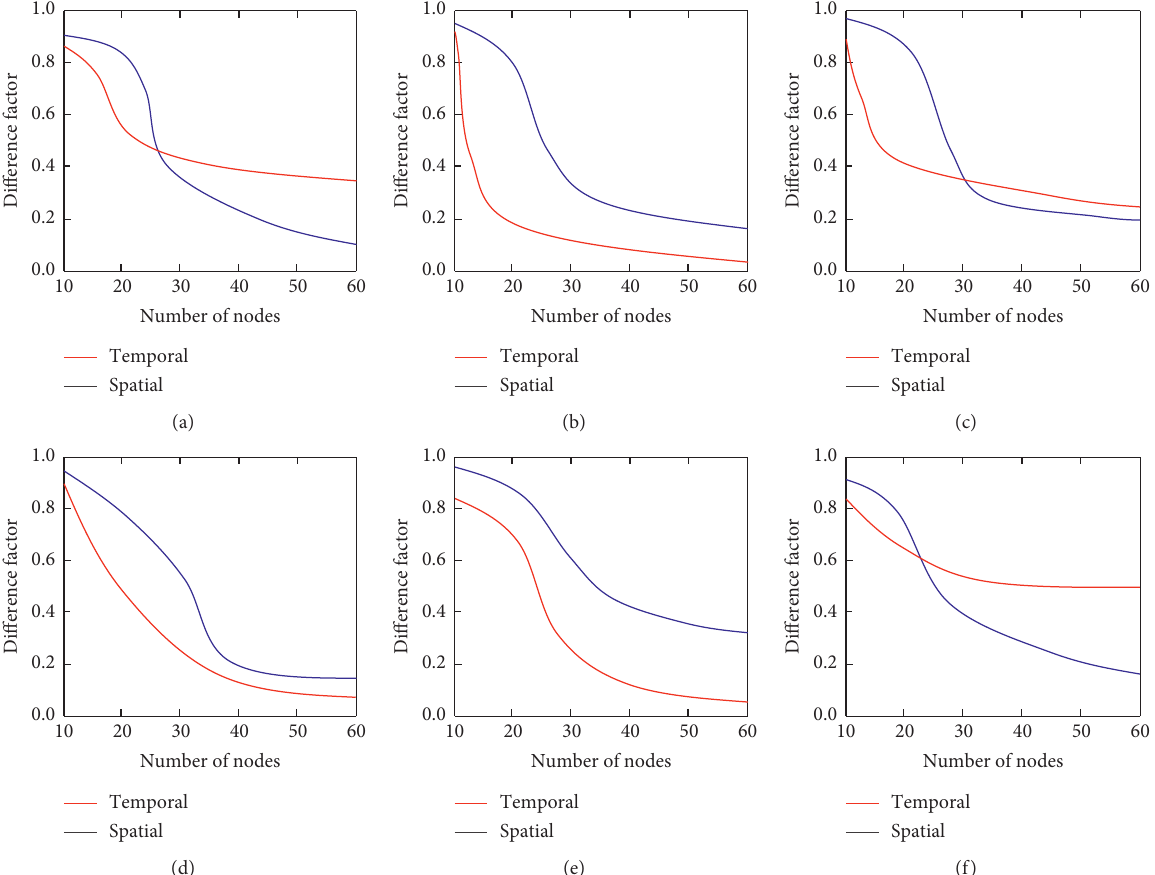
Figure 5: Difference factors of temporal and spatial change of regional economic development with six different intelligent algorithms. (a) Particle swarm algorithm. (b) Chaos optimization algorithm. (c) Ant colony algorithm. (d) Genetic algorithm. (e) Neural network algorithm. (f) Fuzzy